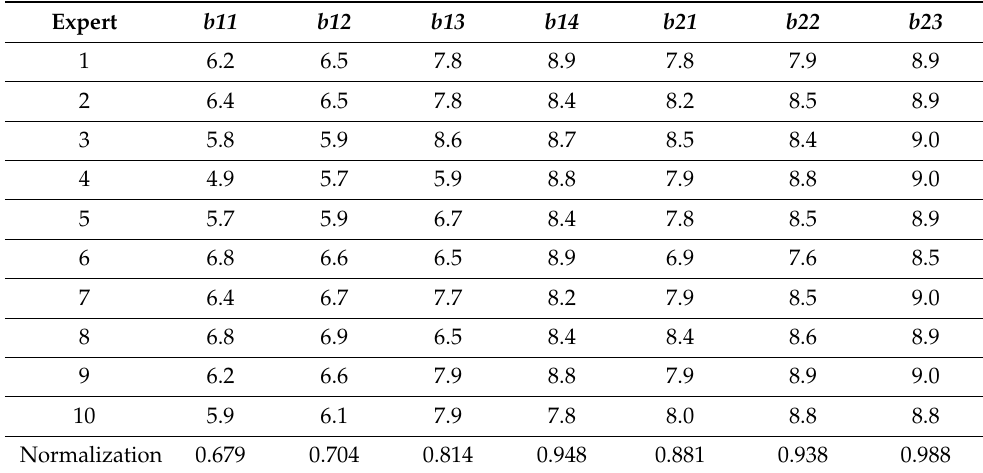
Table 4. Expert scoring of safety risk evaluation indicators for steel bracing.